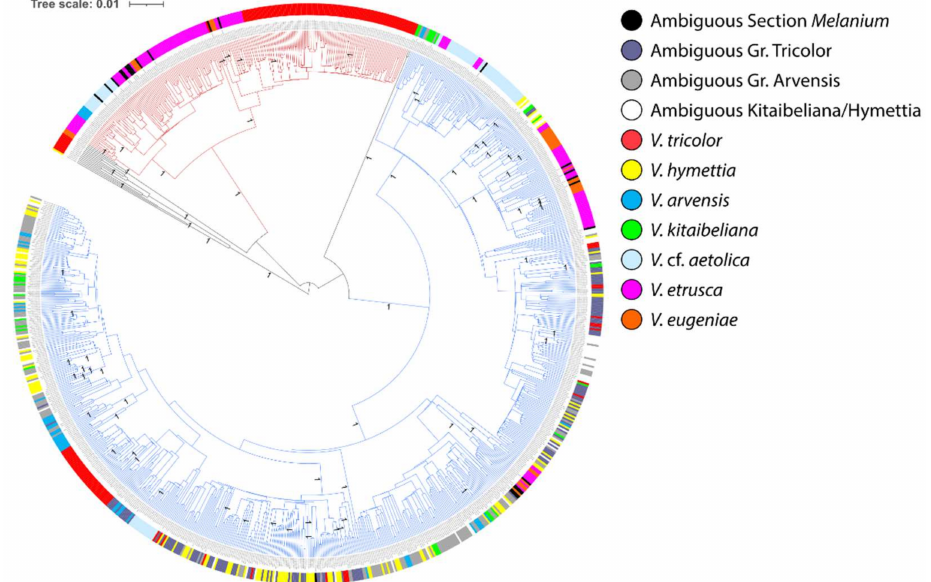
Figure 6. BEAST phylogenetic dendrogram of the 989 5S-IGS filtered for abundance ( ≥ 25) and length ( ≥ 280 bp) in the investigated dataset. Nodes Posterior Probabilities are reported. Major deep clades are evidenced in red and